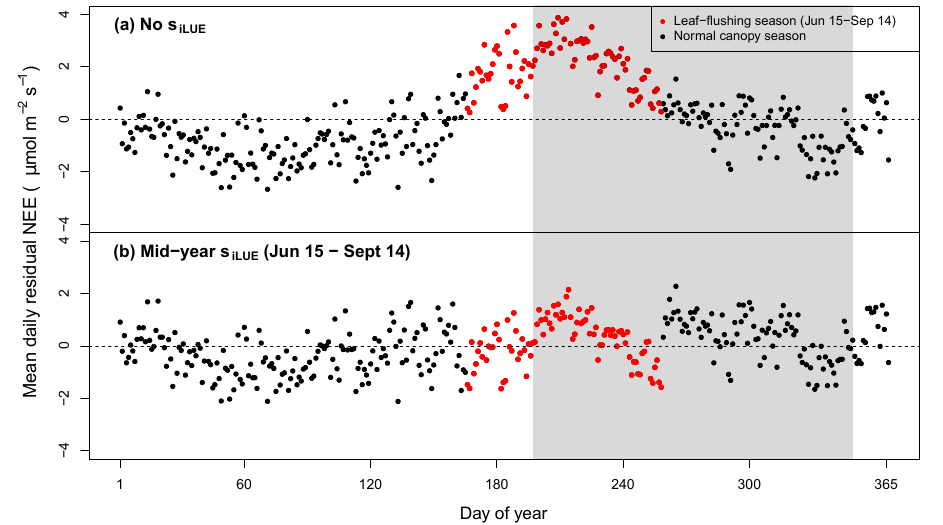
Figure 5. Mean daily data–model residuals averaged over all 7.5 years: (a) lacks an adjustment for phenological change in LUE. Leaf-flush period only partially overlaps the dry season (gray shaded area). (b) The best-fitting parameterization of the model contained a midyear phenology scaling factor (1 − k pheno · s pheno = 0 . 84; Table 2), which was asynchronous with the dry season (red points).